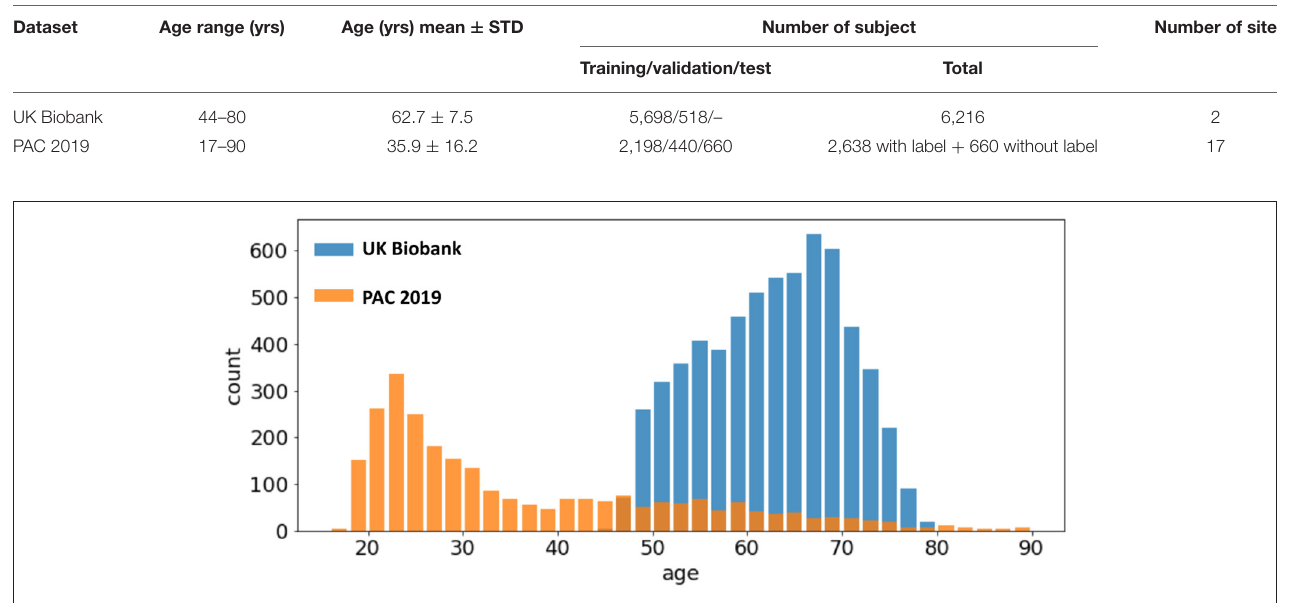
FIGURE 1 | Age distribution of different datasets. The UK Biobank (blue bars) and the PAC 2019 (orange bars) differ in age range and number of subjects.